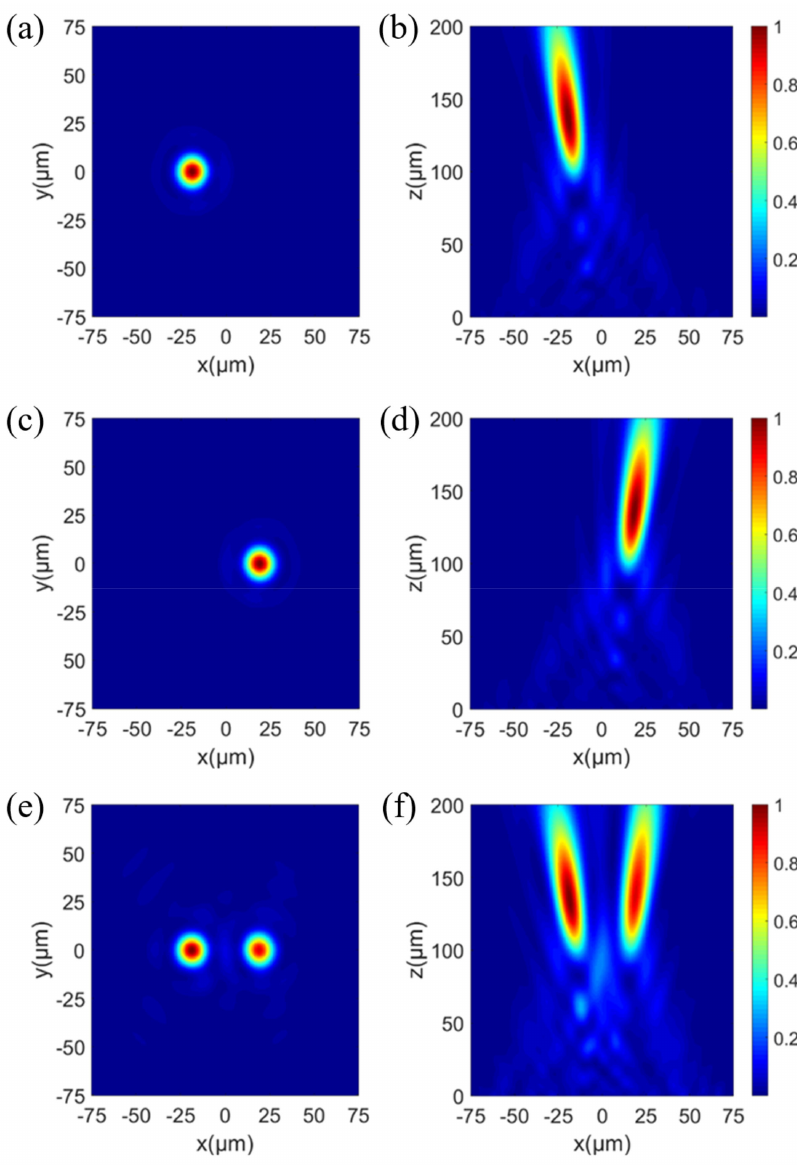
Figure 6. When RCP light, LCP light and 45 ◦ linearly polarized light successively pass through the OCPM, the normalized distribution of the square of the electric field intensity: ( a , c , e ) X − Y plane; ( b , d , f ) X − Z